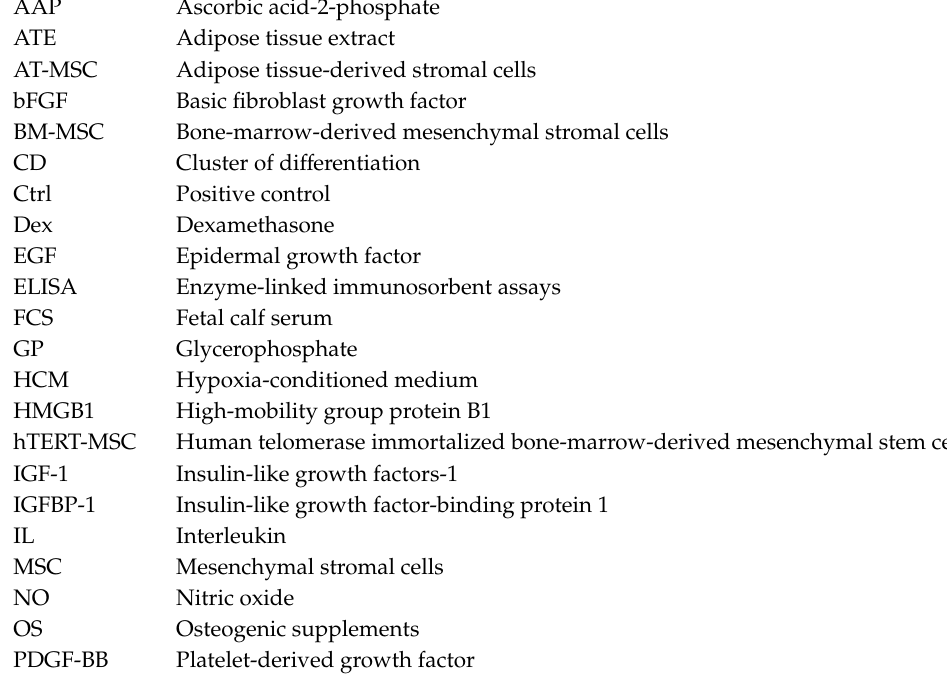
s1. Table S1: Results of the proteome profiler array of 55 human angiogenesis-related proteins (Proteome Profiler Human Angiogenesis Array Kit, R&D, Minneapolis, MN, USA), Table S2: Results of the proteome profiler array of 36 cyto- and chemokines (Proteome Profiler Human Cytokine Array Kit, R&D, Minneapolis, MN,